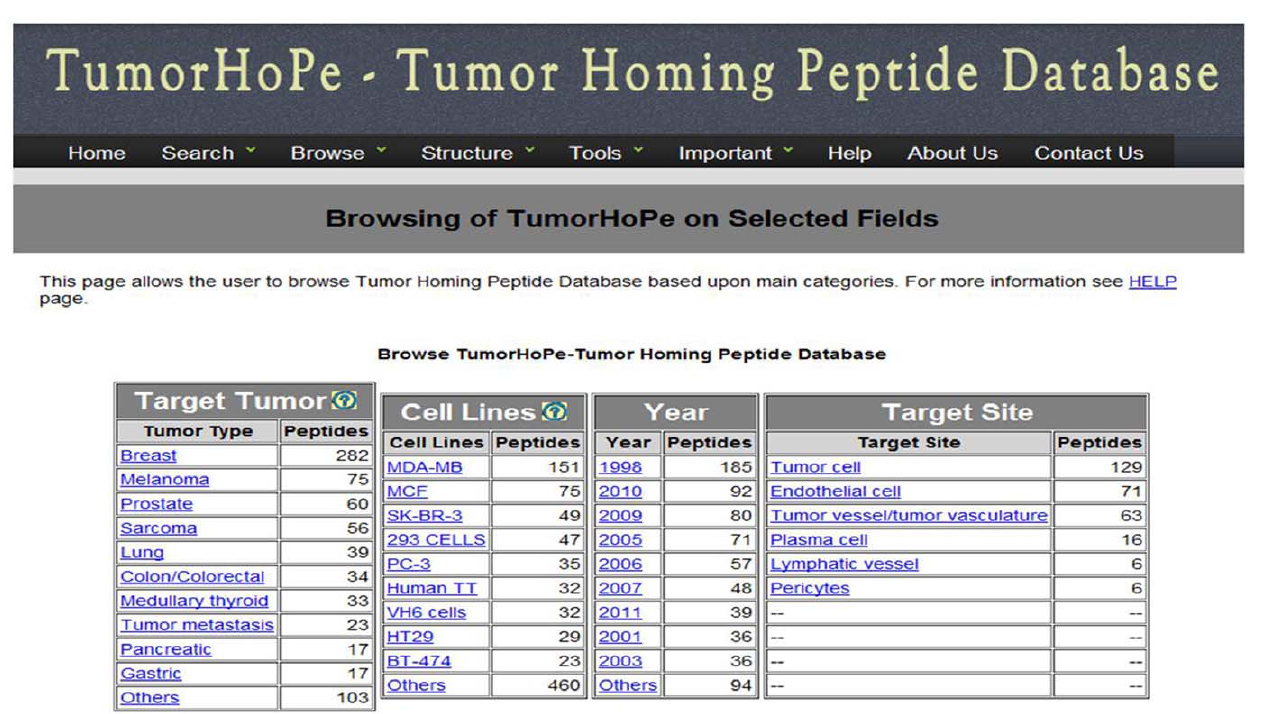
Figure 2. Screenshot of major fields page of TumorHoPe.